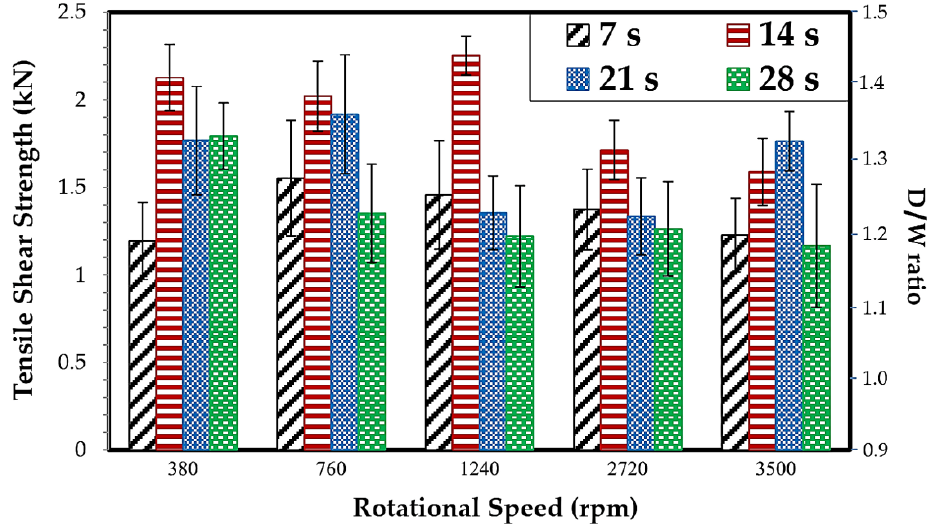
Figure 7. Diagram showing ensile shear strength relationships with D/W ratio by FSSW of the SSM6061 aluminum alloy.